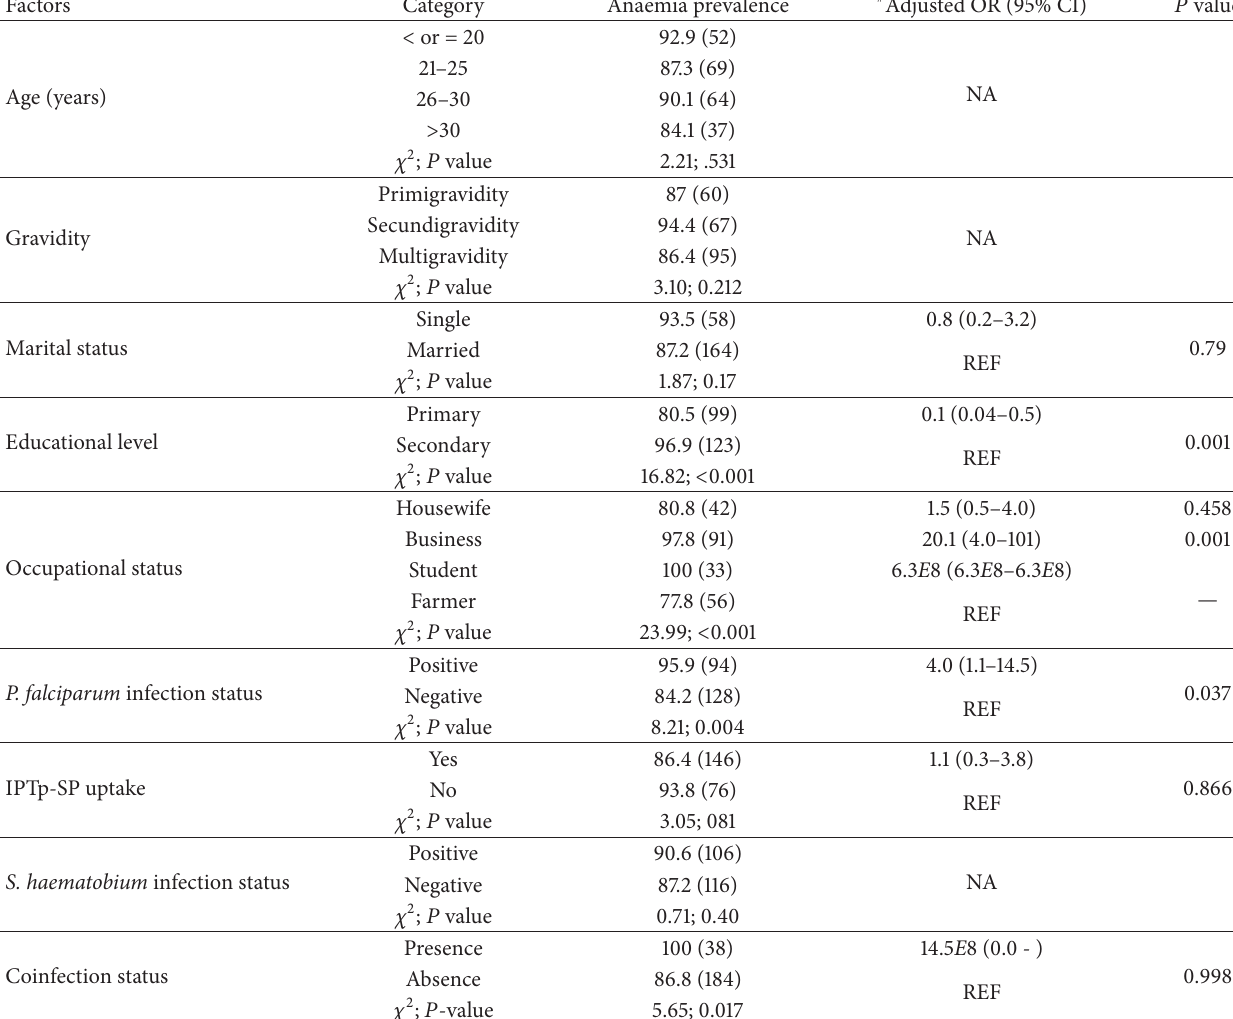
Table 6: Risk factors associated with anaemia among pregnant women in Munyenge Health